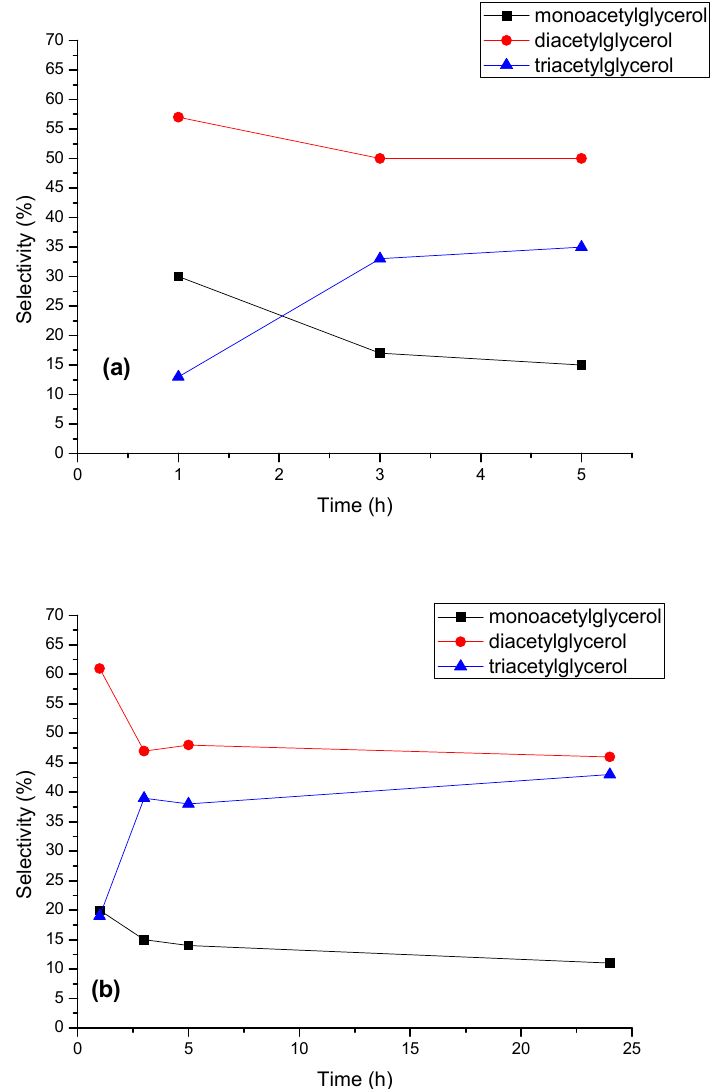
Figure 8. Selectivity of acetylated products over ( a ) Zr 3 (PO 4 ) 2 (SO 4 ) 3 and ( b ) Zr 4 (PO 4 ) 2 (SO 4 ) 5 . Glycerol conversion was complete (100%).